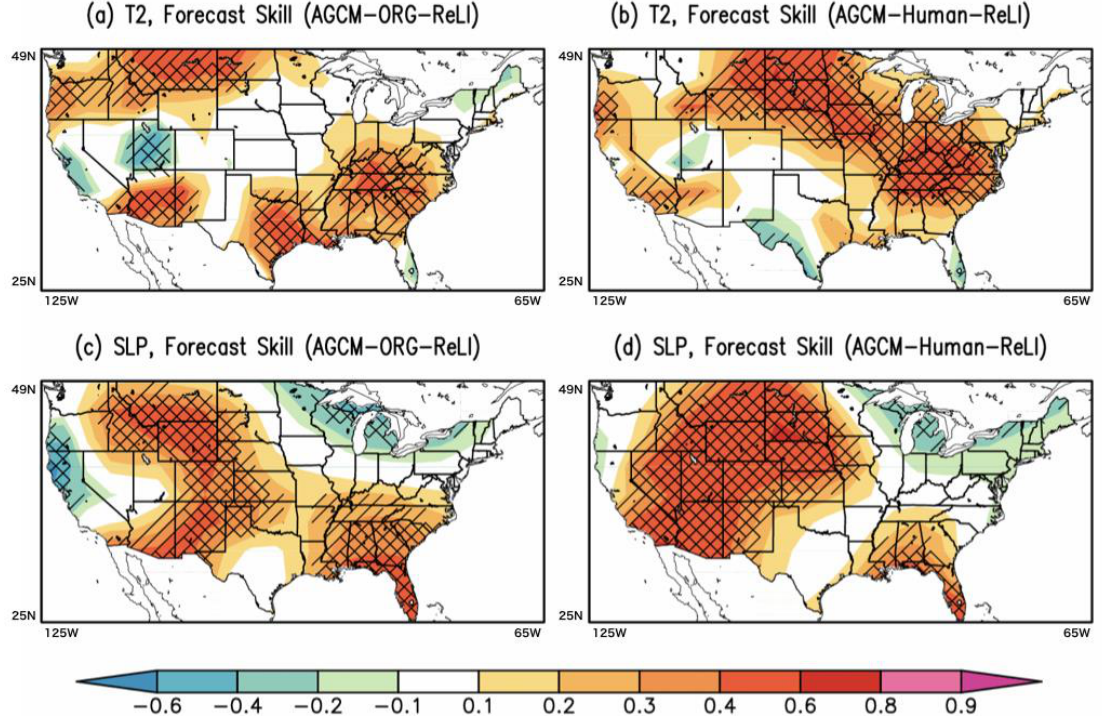
Figure 5. Forecast skill of near-surface air temperature and sea level pressure during the period from Days 16–39 from the initial date of the forecast simulations for ( a ), ( c ) AGCM–ORG–ReLI and ( b ), ( d ) AGCM–Human–ReLI between 1986 and 1995. Areas with single (double) diagonal lines were statistically significant at the 95% (99%) level upon performing a Student’s t -test.